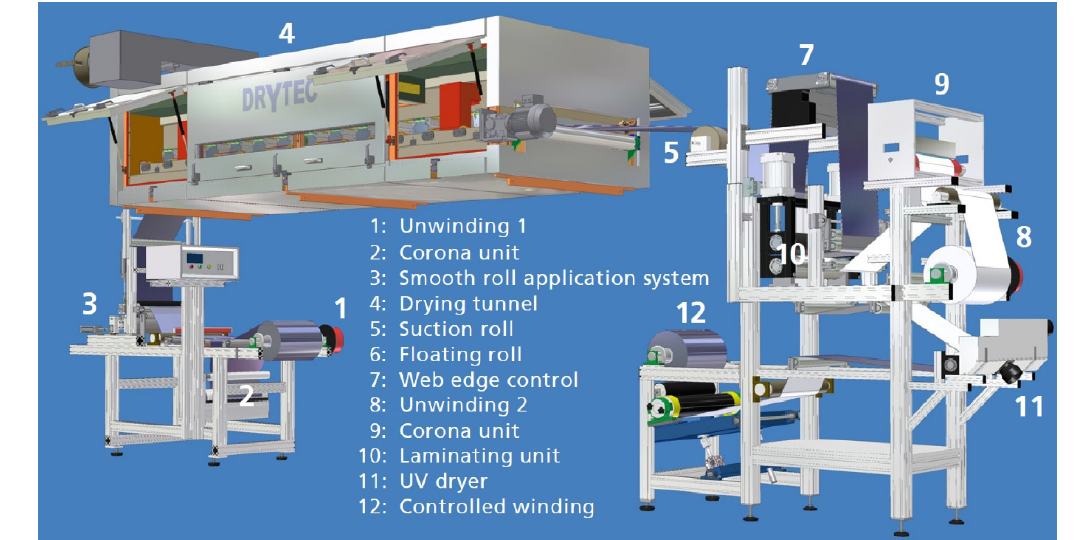
Figure 3. Schematic illustration of the used pilot plant for lacquering and lamination. The layer thickness of the applied adhesive was determined by analyzing microtome cuts. For this purpose, 20 µm thick microtome cuts were made with the Jung Autocut 2055 device from Leica Microsystems GmbH (Wetzlar, Germany), which were then analyzed with an optical microscope with lenses having 40× and 200× magnification.